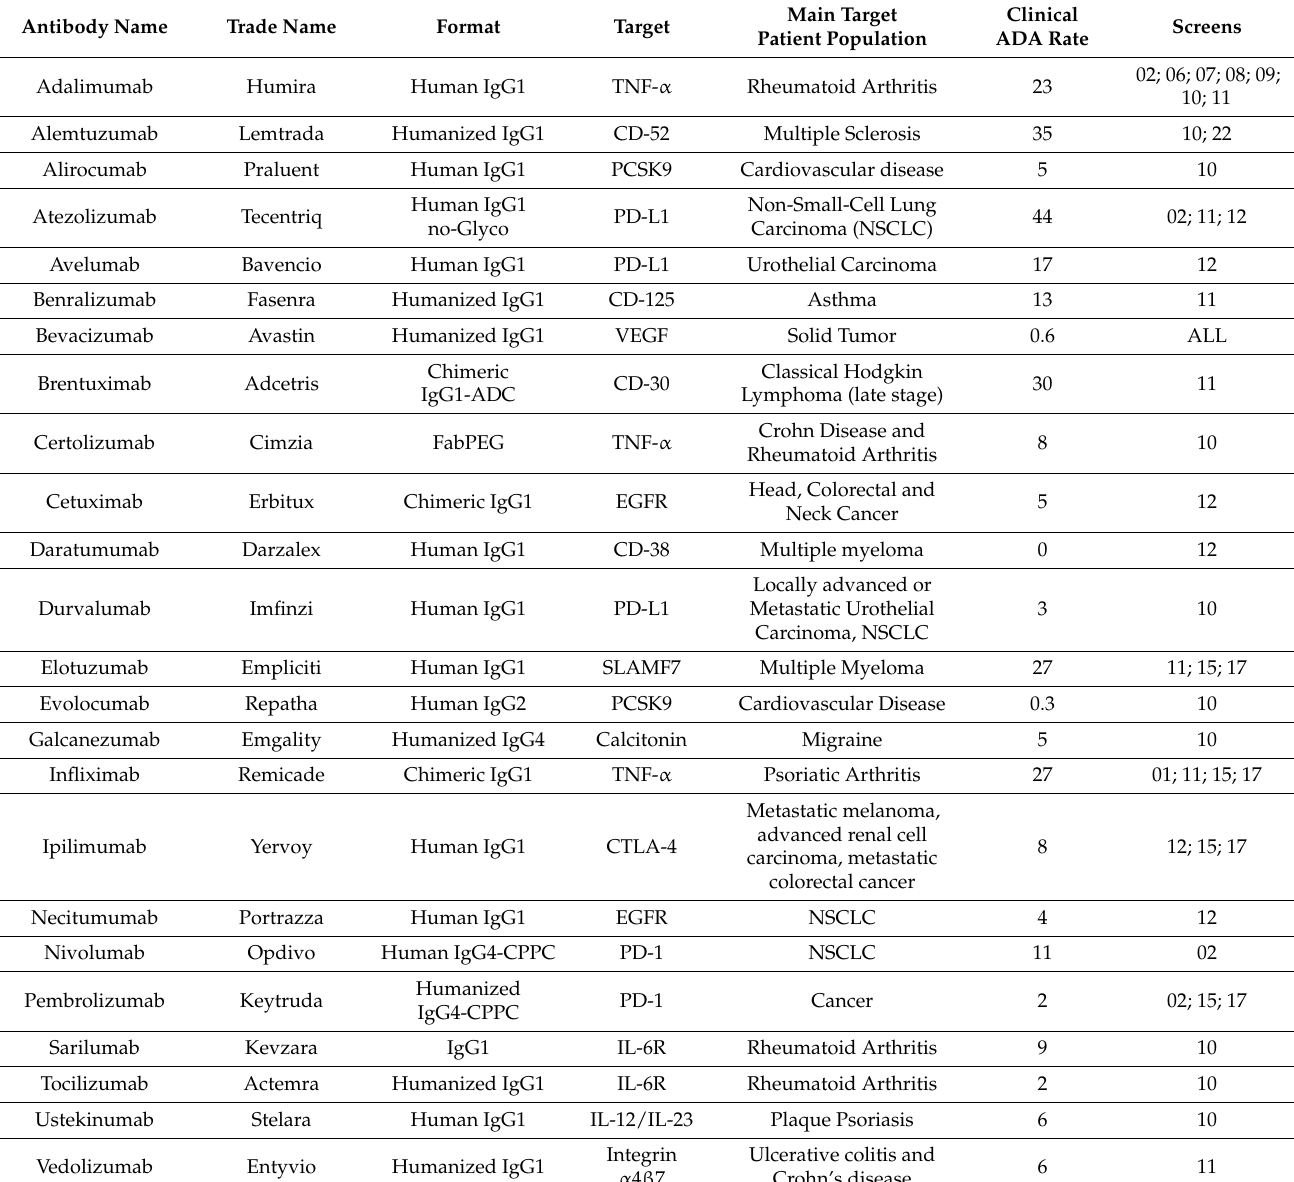
Table 1. Overview of the test items and their respective clinical ADA rates. Alemtuzumab, cetuximab, daratumumab, elotuzumab, sarilumab and tocilizumab are part of a co-treatment. Therefore, con- sideration should be taken when looking at the reported ADA rates. The information was extracted from FDA labels [13]. If several clinical ADA rates were reported, studies mentioning a co-treatment were excluded and the mean value for the remaining study outcomes was taken. In many cases, larger deviations may be due to systematic differences in the treated patient populations, as well as different analytical